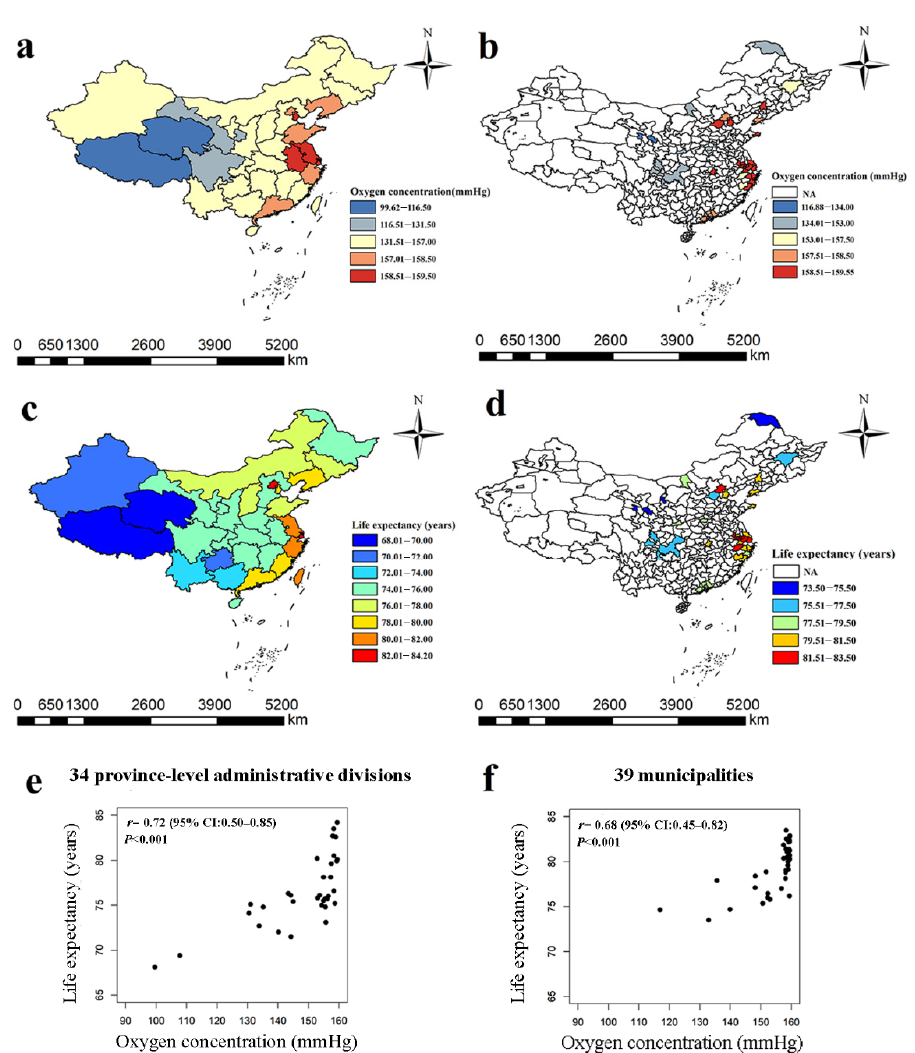
Figure 1. Distribution maps and scatter plots of life expectancy versus oxygen concentration at the provincial and municipal levels in China. ( a ) Oxygen concentration in 34 provinces; ( b ) Oxy- gen concentration in 39 municipalities; ( c ) Life expectancy in 34 provinces; ( d ) Life expectancy in 39 municipalities; ( e ) Scatter plot of life expectancy and oxygen concentration in 34 provinces; ( f ) Scat- ter plot of life expectancy and oxygen concentration in 39 municipalities. In ( e , f ), r (95% CI) and p value are the results of the Pearson correlation tests calculated by R (version